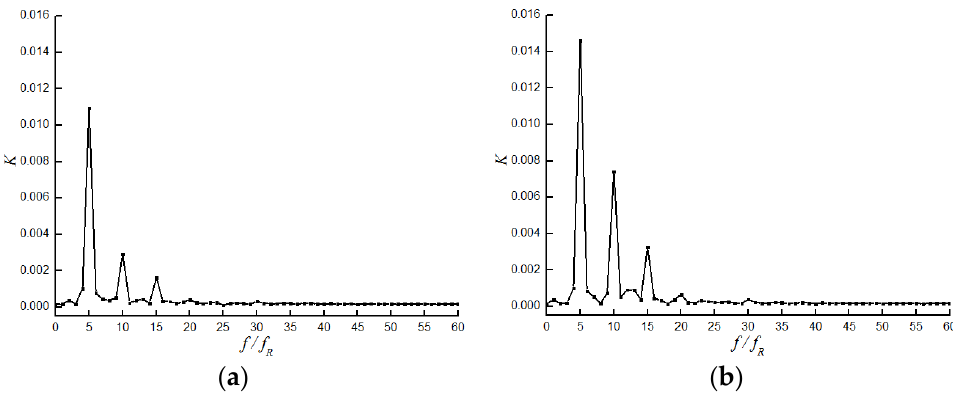
R . ( a ) Impeller. ( b ) Housing.